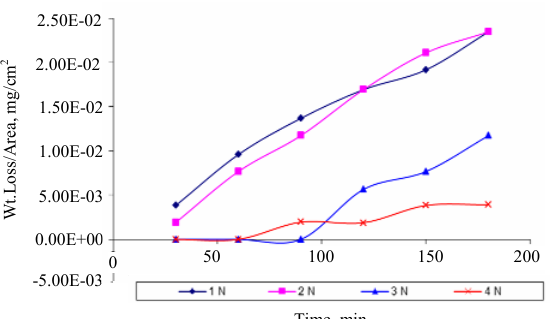
Figure 3. Effect of concentration of potassium hydroxide on corrosion rate